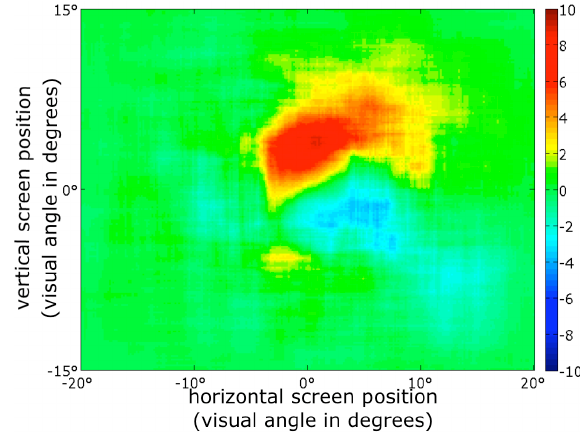
Figure 3. Dwell time contrast map. Red indicates locations on the screen where participants dwelled longer during beauty judgments, blue locations where participants dwelled longer during roughness judgments. Effects are non-significant ( p = 0.12 for the maximum, and p = 0.89 for the minimum, FWE- corrected). Figure 4. Eye movement parameters. Increases during